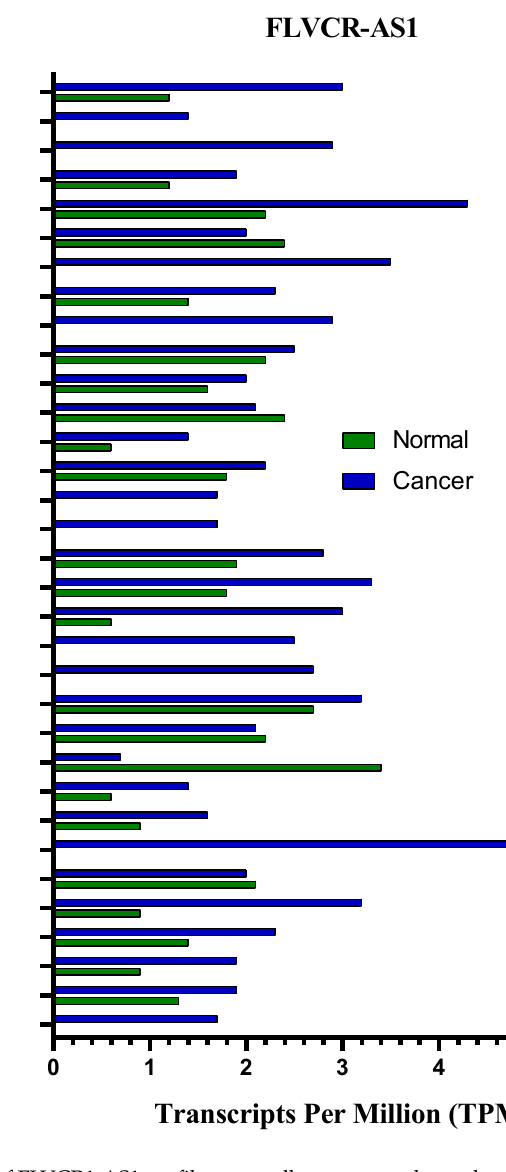
Figure 3. The gene expression of FLVCR1-AS1 profile across all tumor samples and paired normal tissues.